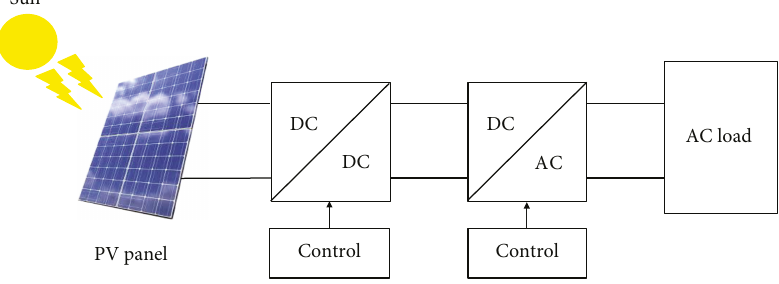
Figure 1: Standalone PV